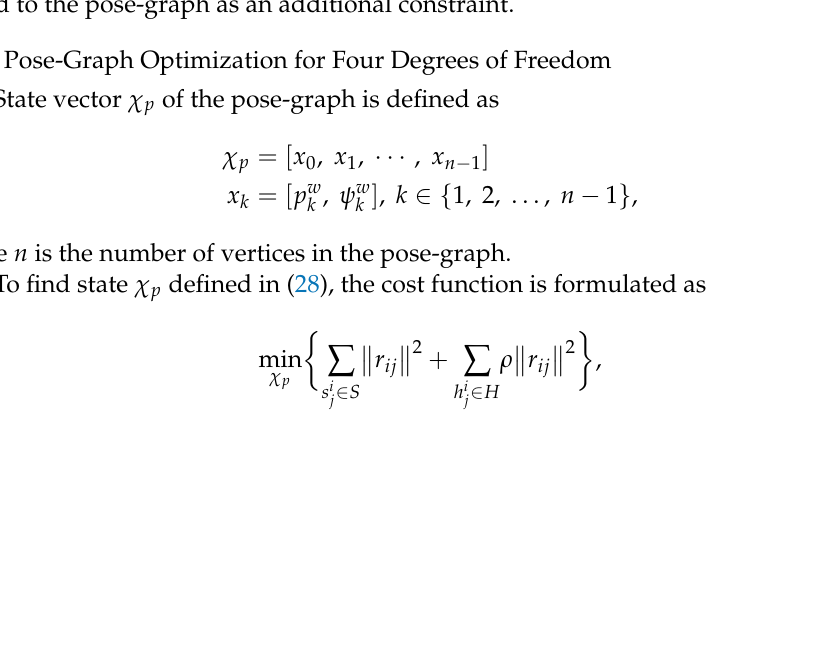
(cid:111) (cid:110) h 0 , · · · k + 1